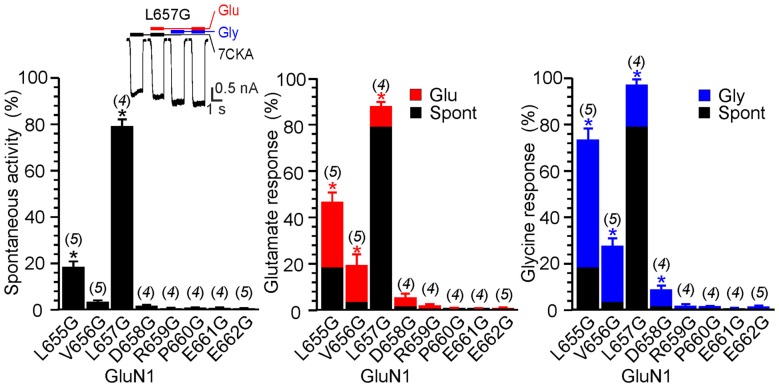
The effect of glycine mutagenesis of the GluN1 M3-S2 linker. Summary graphs of the mean ± SEM (n) of the relative responses—RISpont (black columns), RIGlu (red columns) and RIGly (blue columns; see Equation 1–3)—in receptors with a single residue mutated to glycine in the GluN1 linker. Inset, representative current response of GluN1(L657G)/GluN2B. Application of ECS containing 7CKA (10 μM) with no added Mg2+, glutamate, or glycine is indicated by a black bar (7CKA); application of 1 mM glutamate and 7CKA (10 μM) with no added Mg2+ or glycine is indicated by a red bar (Glu); application of 0.1 mM glycine with no added Mg2+ or glutamate is indicated by a blue bar (Gly). In between the applications of Mg2+-free ECS the cells were bathed in ECS containing 2 mM Mg2+. Differences in the relative responses determined for WT and mutated receptors were statistically significant; one-way ANOVA (P < 0.001); followed by multiple comparisons of the relative responses of mutated receptors vs. WT (RISpont 0.44 ± 0.06 (n = 24); RIGlu 0.63 ± 0.30 (n = 24); RIGly 1.1 ± 0.2 (n = 24)); Dunnett’s test; *P < 0.050.